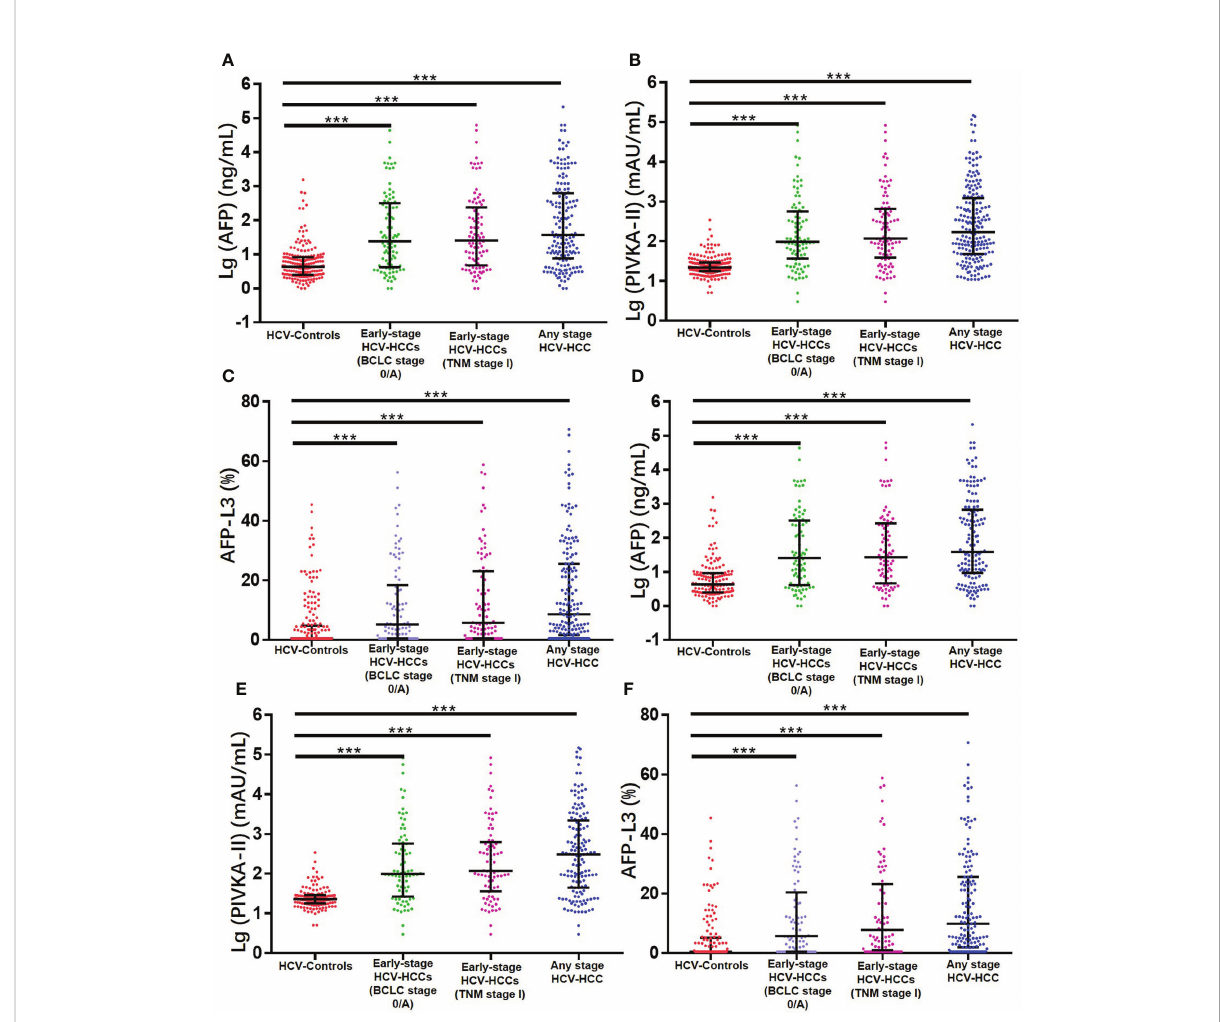
FIGURE 2 Serum concentrations of three serum biomarkers in the overall group (A) AFP; (B) PIVKA-II; (C) AFP-L3% and in the cirrhosis subgroup (D) AFP; (E) PIVKA-II; (F) AFP-L3%. *** P <